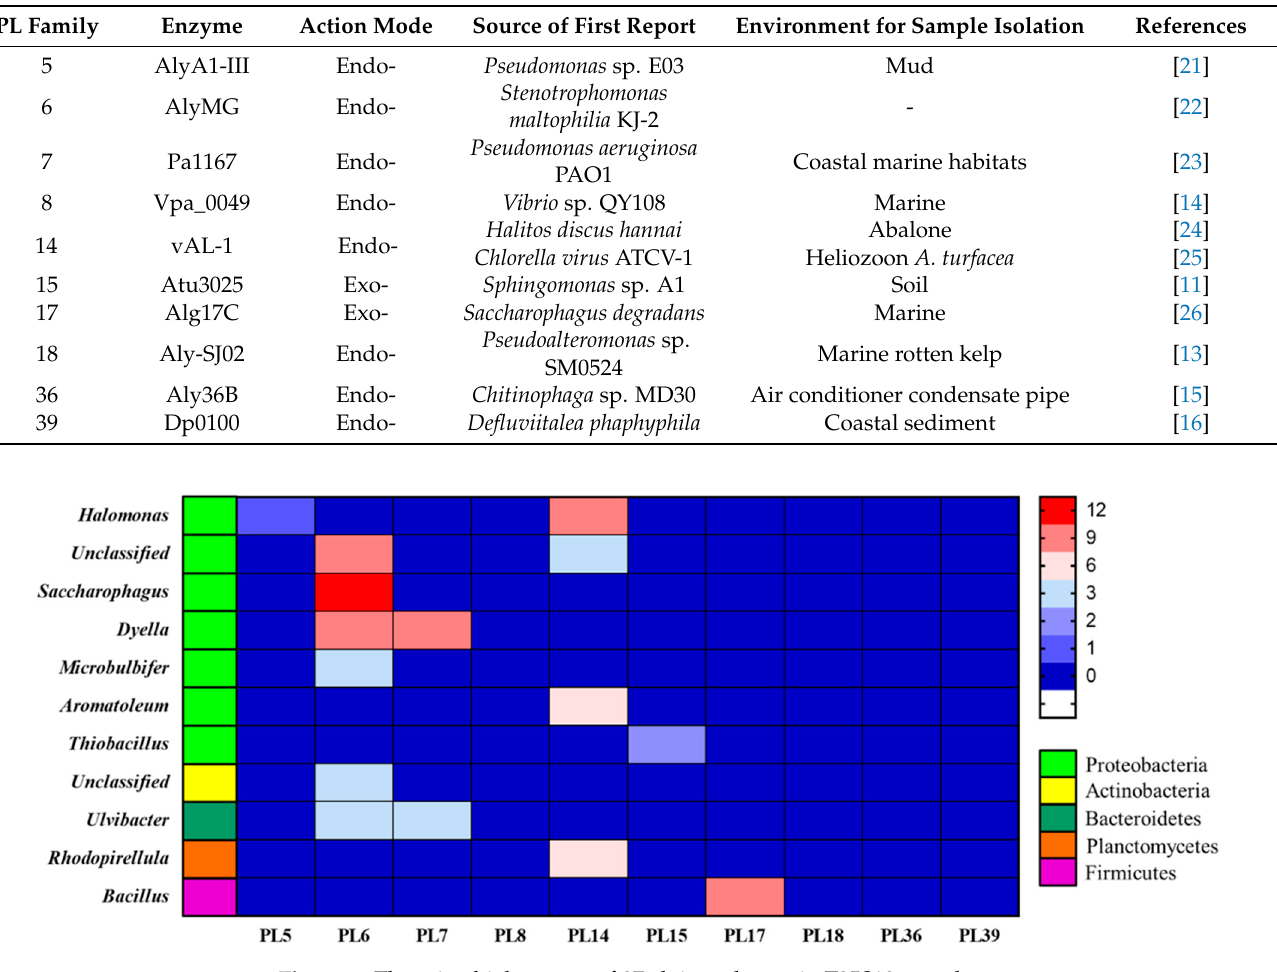
Figure 5. The microbial sources of 87 alginate lyases in T25S10 sample .